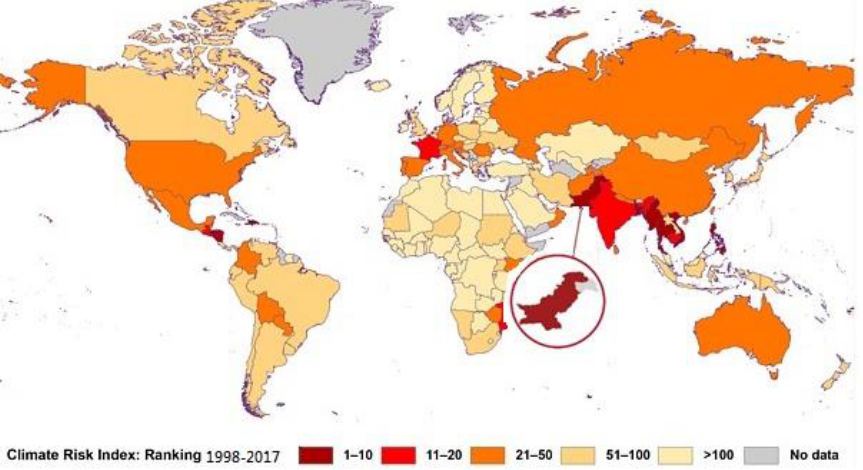
Figure 1. Climate Risk Index: CRI of 2019 analysis the extent to which countries has been affected by weather-related losses between 1998 and 2017.